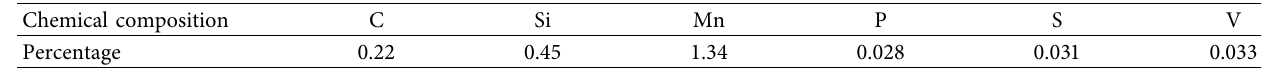
Figure 2: An actual specimen and its dimension (unit: mm). Table 1: Chemical composition of HRB400 bars.